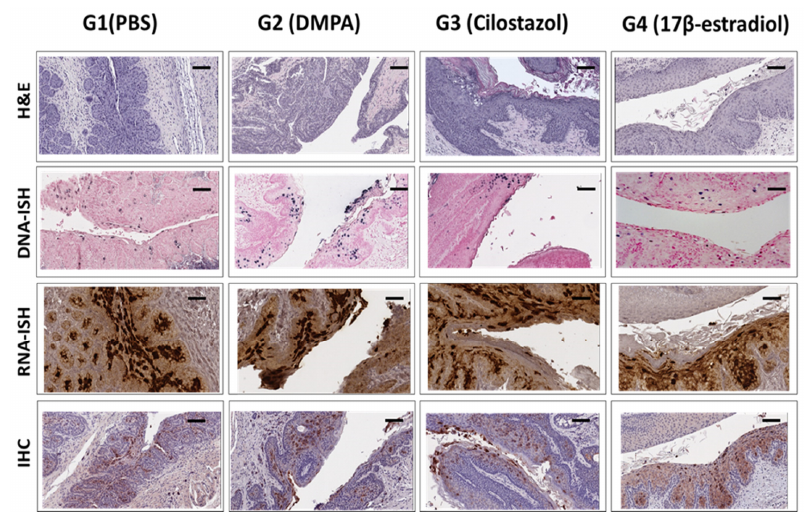
Figure 7. Comparable viral signals (RNA, DNA and protein) were detected in the lower genital tissues of different groups. Athymic Hsd:Nu Mice with equivalent weight were distributed into four groups ( n = 5), treated with PBS (group 1), DMPA (group 2), Cilostazol (group 3), and17 β -estradiol (group 4) at one month post viral infection and for up to nine months. Vaginal tissues were har- vested for histological, virological, and immunological analyses. Representative images for each group are shown here. The top panel shows H&E staining. Diffuse positive mild to moderate atypia with persistent differentiation toward lumen was found in group 1. Diffuse mild to moderate atyp- ical hyperplasia of the caudal half of the vagina with extension into the adjacent haired skin was found in group 2 and 3. Adjacent to the vagina there is a tissue with florid hyperkeratosis and prom- inent viral CPE (interpreted as an en face section of caudal vagina). Rare small foci that may repre- sent microinvasion and desmoplasia were found in group 4. Viral DNA (the second panel), RNA (the third panel), and E4 protein (the bottom panel) were detected by in situ hybridization (ISH) and immunohistochemistry (IHC), respectively. No significant difference was found among the four groups at the termination of the experiment at nine months post treatment. Scale bar = 100 µm. Similar results were observed in the anal tissues as shown in Figure 8. No significant difference in viral DNA, RNA as well as MmuPV1E4 immunostaining was found among the groups ( p > 0.05, Wilcoxon rank sum test).